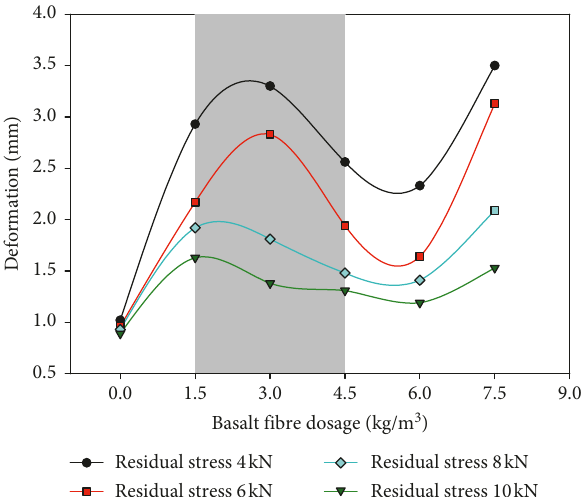
Figure 7: Deformation energy of DBV-1998.